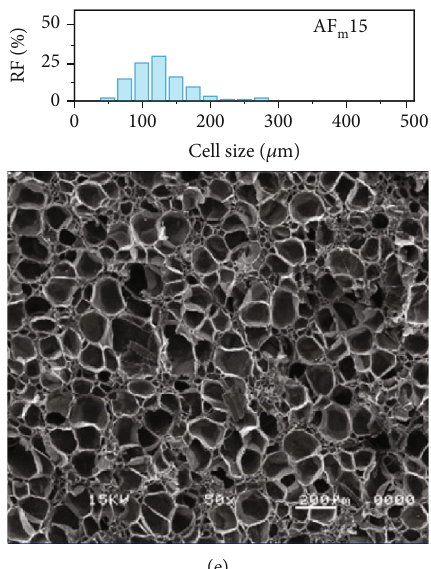
Figure 4: SEM micrographs of composite foams at di ff erent AF